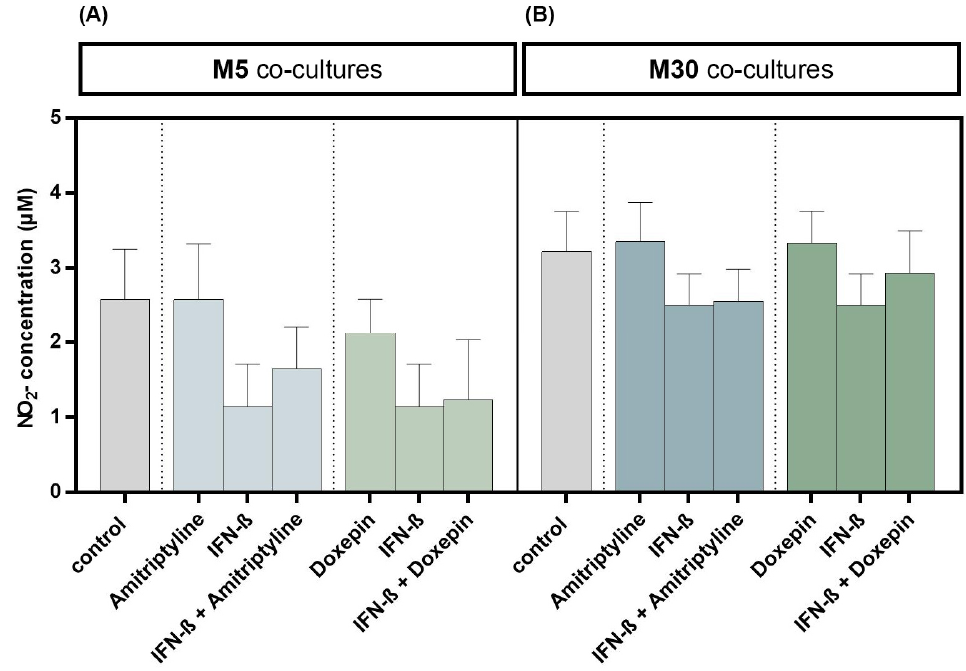
Figure 6. Nitric oxide (NO) concentration determined based on measurement of nitrite (NO 2 ) as a primary breakdown product of NO using Griess (NO) assay in the physiological (M5) ( A ) and pathological (M30) ( B ) astrocyte–microglia co-cultures after incubation with 10 ng/mL amitriptyline or 10 ng/mL doxepin for 2 h, or with 2000 U/mL interferon- β (IFN- β ) for 22 h. Incubation with the antidepressants or IFN- β alone did not result in significant changes in NO 2 concentrations in physiological ( A ) or pathological ( B ) co-cultures ( n = 9). Moreover, the co-incubation with amitriptyline or doxepin of IFN- β pre-treated co-cultures did not lead to NO 2 changes ( n = 9). Untreated co-cultures were used as controls. The individual experimental conditions were compared by two-tailed t -test. No significant differences between the individual conditions were detected ( p = ns).